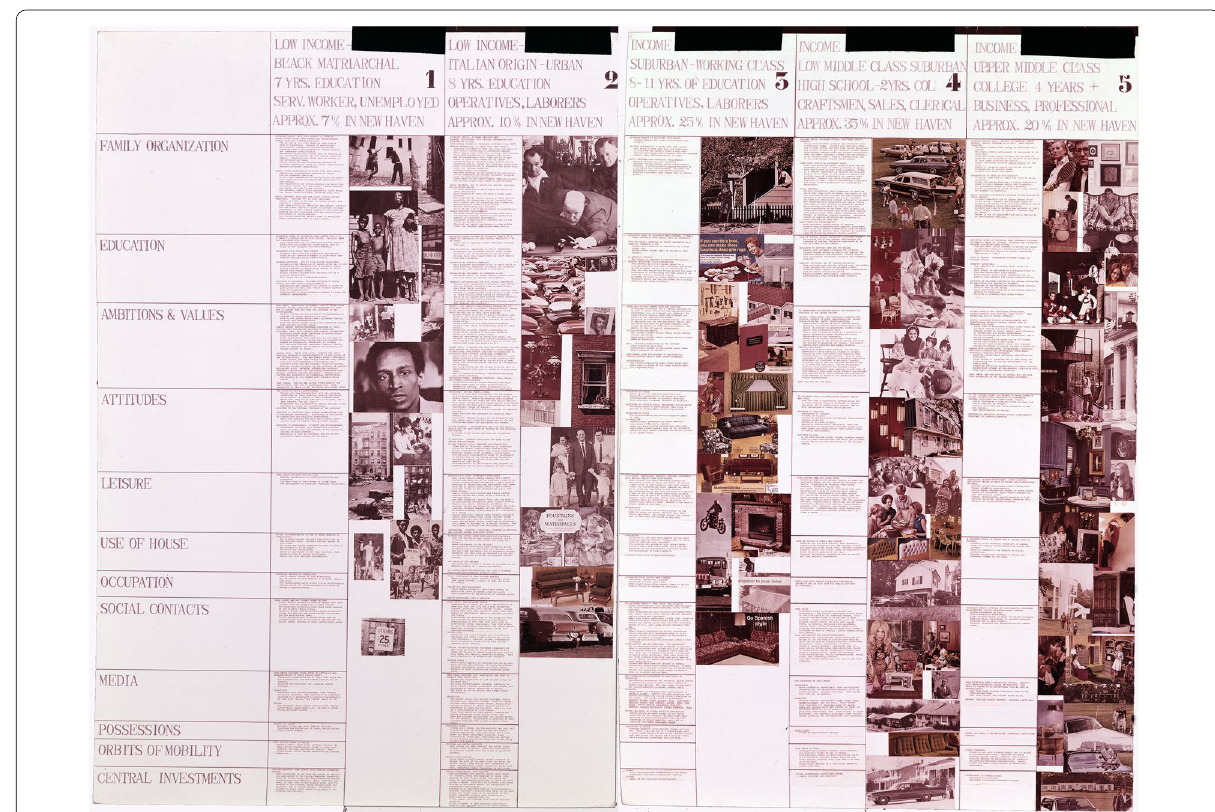
Fig. 6 Robert Venturi, Denise Scott Brown, and Steven Izenour, learning from Levittown Studio, Fall 1970. Life styles expressed in the house. Credits: Venturi, Scott Brown Collection, The Architectural Archives, University of Pennsylvania. https:// www. design. upenn. edu/ archi tectu ral‑ archi ves/ ventu ri‑ scott‑ brown‑ and‑ assoc